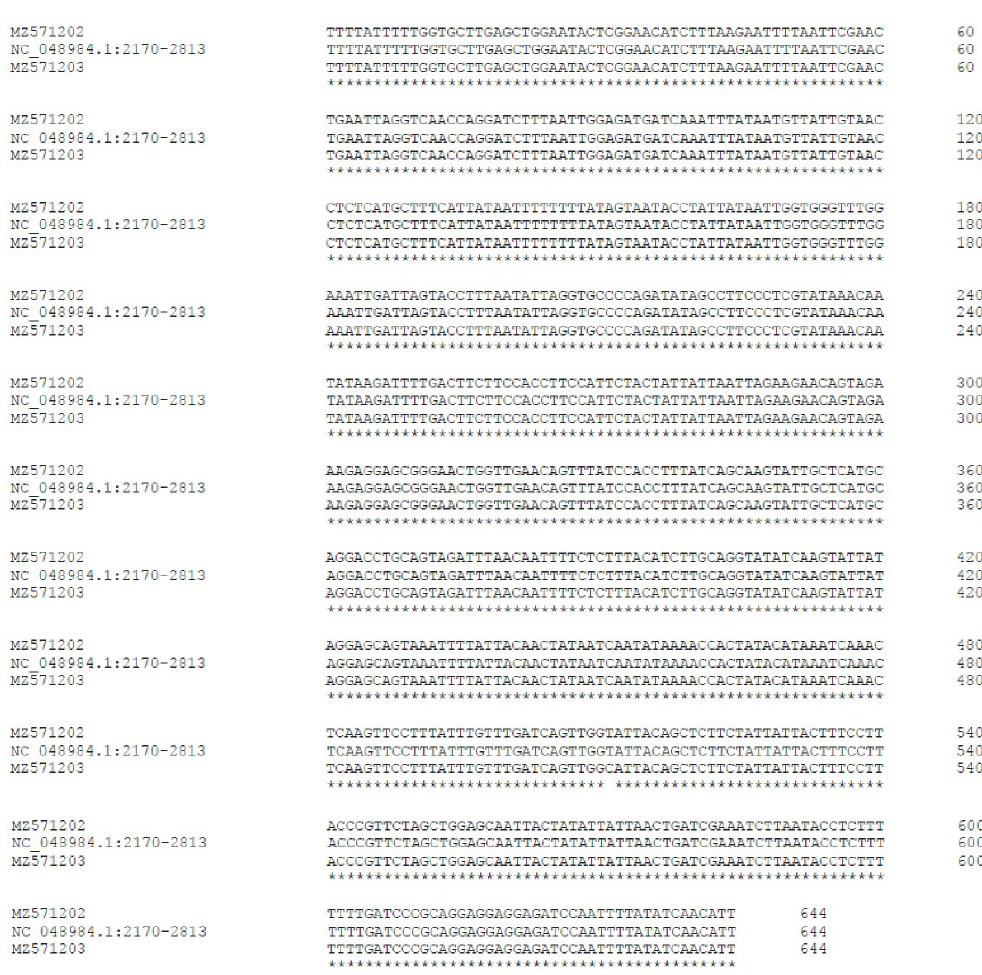
pole (Fig 3A). To measure whether the trivalent had a balanced attachment, we estimated the position of the spindle poles by locating the vertices of the cleared region of the cell (the spin- dle excludes phase-dense organelles like mitochondria, so it is straightforward to estimate the position of poles by looking where the cell is cleared). The distance between the spindle poles was measured and then a line perpendicular to the line between poles was drawn. In all cells that we measured, the X and X chromosomes of the trivalent were positioned adjacent to 1 2 one another, so the level of balance of the chromosome was determined by measuring the dis- tance between the line perpendicular to the spindle axis and the X kinetochores, then measur- ing the distance between the line perpendicular to the spindle axis and the Y kinetochores, and calculating the ratio between the two (Fig 3B). Because the X and X chromosomes in H . 1 2 membranacea are submetacentric (i.e. chromosomes have two arms but centromeres are not equidistant from both chromosome ends), free (unstretched) chromosome arms form an angle with the remainder of the trivalent at the X and X kinetochores. The position of the 1 2